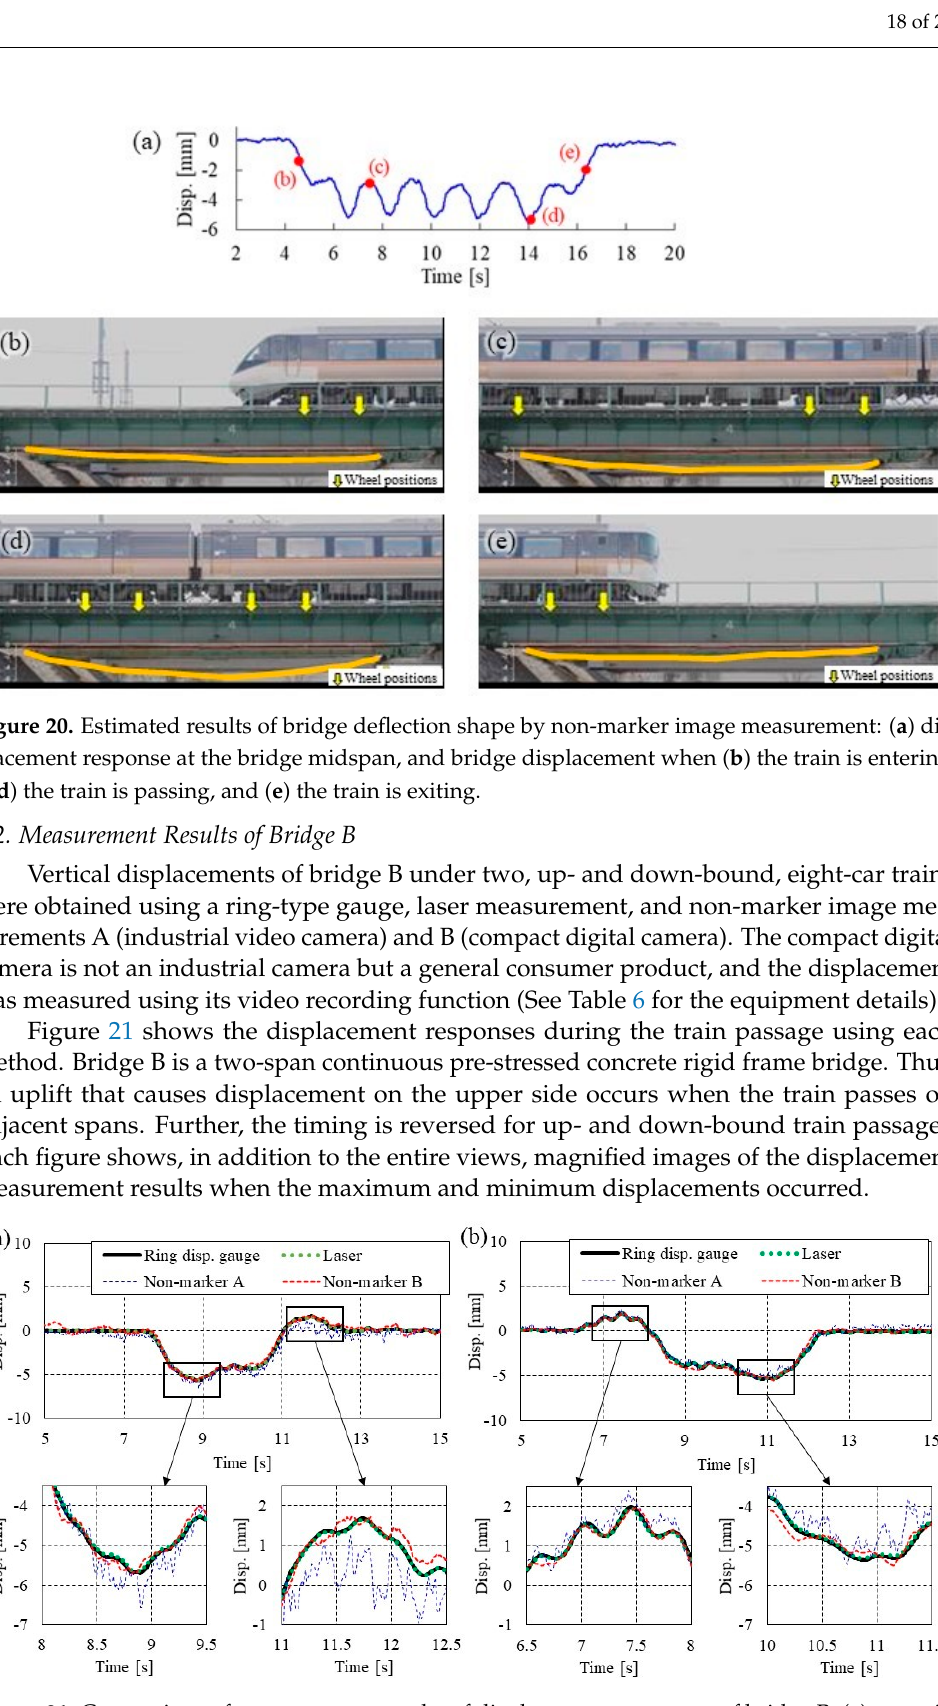
Figure 21. Comparison of measurement results of displacement responses of bridge B: ( a ) up train passing at 220 km/h, ( b ) down train passing at 257 km/h.